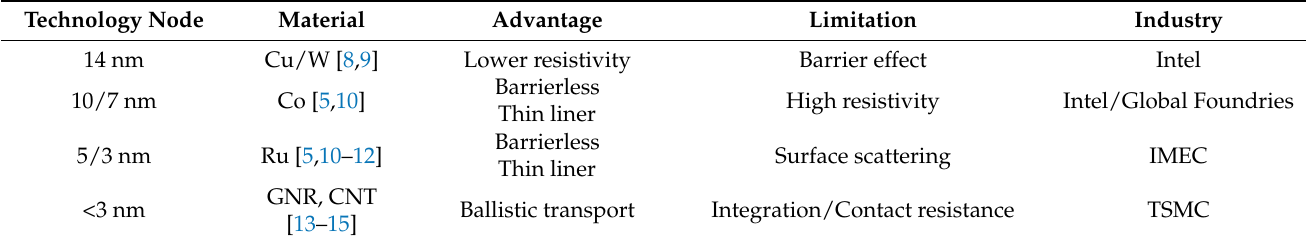
Table 1. The Development of On-chip